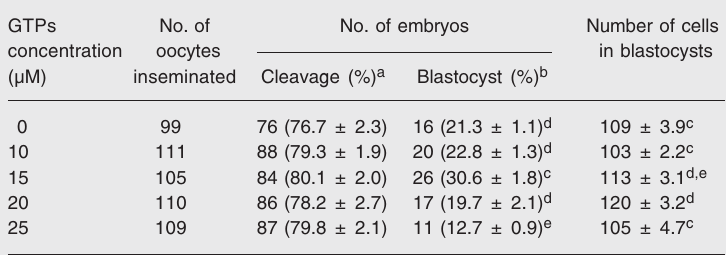
a Number of embryos is reported as median and percent of embryos cleaved as percent of the number of inseminated oocytes (mean ± SEM), or b percent of blasto- cysts as percent of the number of cleaved embryos (mean ± SEM). c,d,e Values with different superscripts within a column are significantly different from each other (P < 0.05, ANOVA followed by the Fisher protected least significant difference